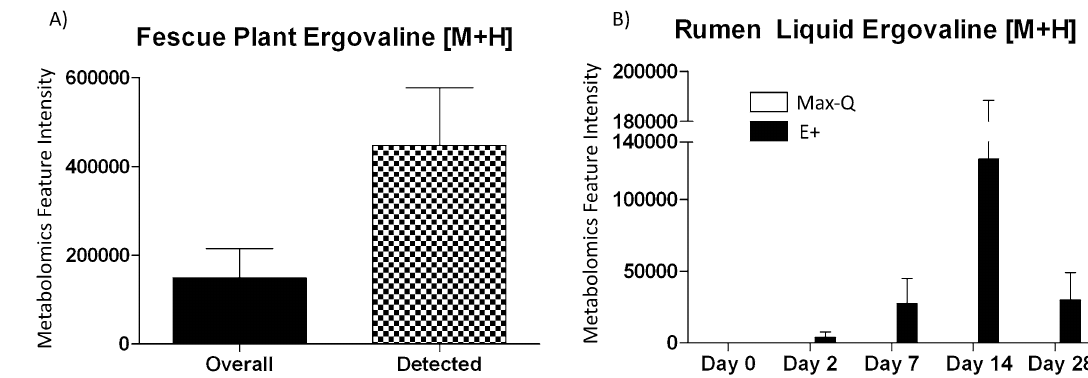
Figure 3. Average putative ergovaline [M + H] feature intensity in ( A ) toxic (E+; n = 18) tall fescue plant for all samples (black) and only in samples where ergovaline was detected (checkered) and ( B ) the rumen liquids of Angus steers grazing either a non-toxic (Max-Q; n = 6) or toxic (E+; n = 6) tall fescue over the course of the 28-day grazing trial. Feature intensity data are presented as mean ± Overlapping microbial and metabolic features. Plant and animal bacterial OTUs did not overlap, but an overlap between plant and rumen fungal OTUs (Max-Q 103 OTUs; E+ 115 OTUs) was present. Substantial overlap occurred between bacterial (332 Max-Q; 378 E+) OTUs in the rumen solids and rumen liquids regardless of fescue cultivar (Fig. 4A,B). Overlapping OTUs between the rumen solids and feces within E+ steers mapped to f_ Coriobacteriaceae , f_ Lachnospiraceae , and f_ Ruminococcaceae families (Fig. 4B). For the fungi, more OTUs overlapped between the grass and rumen liquids than grass and rumen solids in both Max-Q and E+ steers (Fig. 4C,D, respectively) . In E+ steers, one OTU aligned to the Epichloë genus, alongside multiple Phaeosphaeriaceae OTUs, overlapped between these biological matrices. Most OTUs overlap- ping between the fescue grass, rumen solids, and rumen liquids were cultivar specific, including Cryptococcus aureus and Cryptococcus dimennae in E+ (Fig. 4D) . Multiple f_ Neocallimastigaceae OTUs overlapped between all animal matrices irrespective of treatment. Sub-family overlap was largely cultivar-specific, and the full list of overlapping bacterial and fungal OTUs is in File S1. Similar metabolite ( m/z ) overlap was observed for Max-Q and E+ steers. 533 and 543 metabolic features over- lapped between all biological matrices in Max-Q (Fig. 4E) and E+ steers (Fig. 4G), respectively. Of these, 526 were shared, and 7 and 17 were distinct to Max-Q and E+, respectively (Fig. 4F). Among the distinct E+ features were metabolites putatively annotated as: 11-dimethoxydecane ( m/z 102.1042 [M + H]), urea (m/z 121.0718 [2M + H]), L-kynurenine (m/z 209.0921 [M + H]), and (R)-Pterosin B ( m/z 219.1379), plus several unannotated metabolites. Targeted Epichloë and ergovaline correlation network analysis. E. (coenophiala ) targeted network analysis in the fescue plant revealed one highly interconnected network of 29 fungal and 31 bacterial OTUs (Fig. 5A). Of